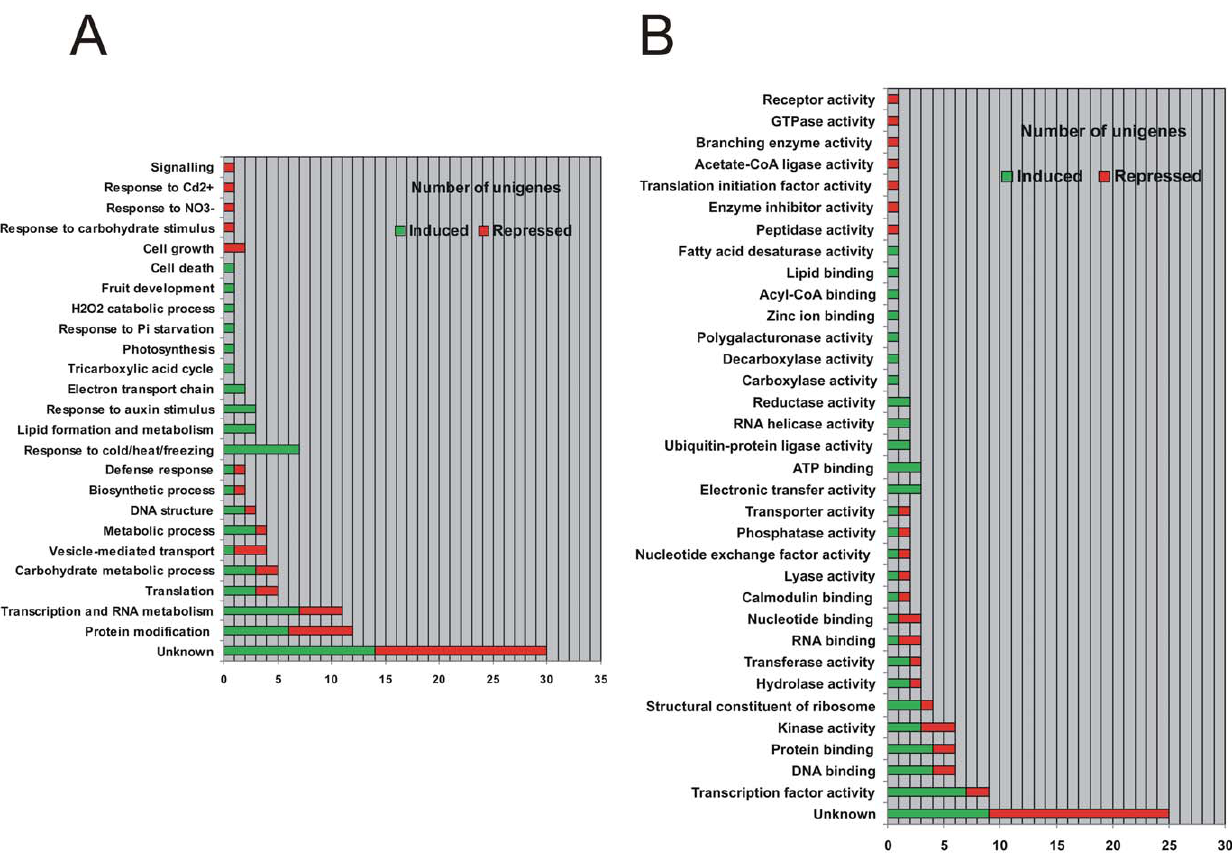
Figure 2. GO-term functional distribution of the heat-responsive unigenes. The top BLAST hits of the 105 differential expressed unigenes from the IG and RG were classified according to the GO term in biological processes ( A ) and molecular functions ( B ) vocabularies of their Arabidopsis thaliana orthologous.